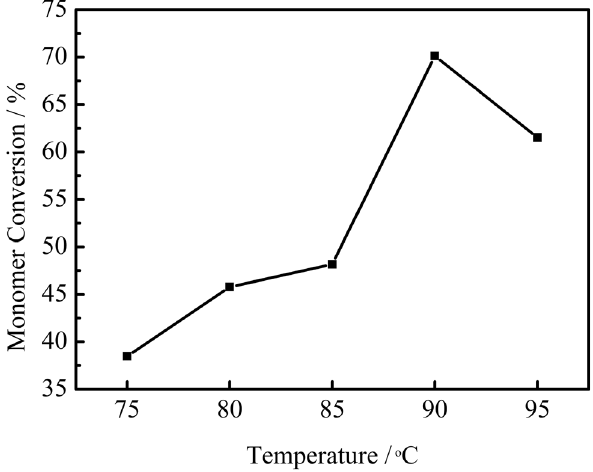
Figure 2: E ff ect of polymerization temperature on styrene conversion.